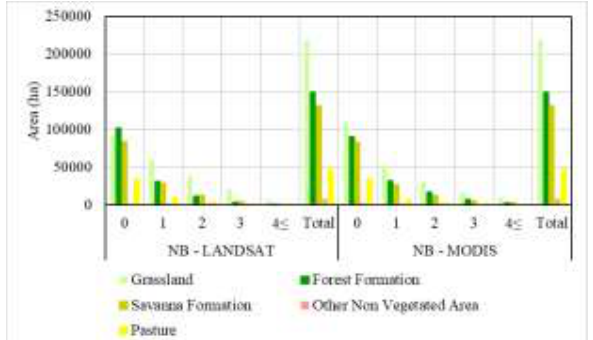
Figure 5. Land use and land cover classes that most burned between 2007 and 2017 at the QKG and its surroundings. NB: Number of times it has suffered burns, according to LANDSAT and MODIS